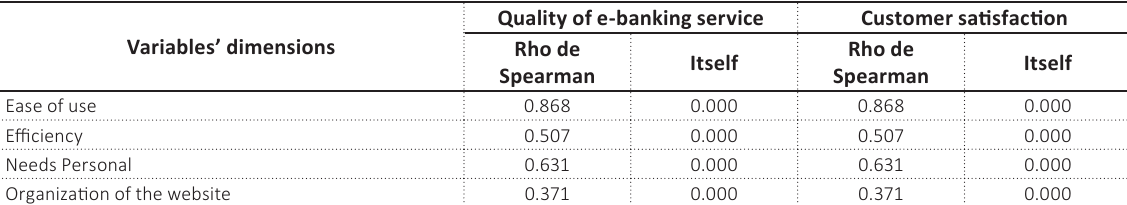
Table 6. Correlation coefficient using Spearman’s Rho on e-banking service quality dimensions and customer